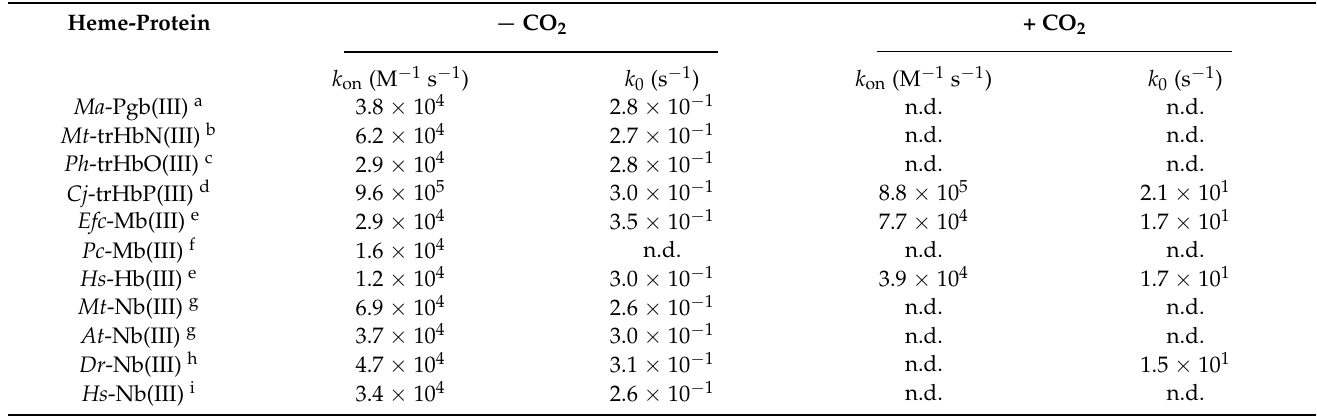
Table 2. Effect of pH and CO 2 on values of k on and k 0 for heme-protein-induced isomerization of peroxynitrite.